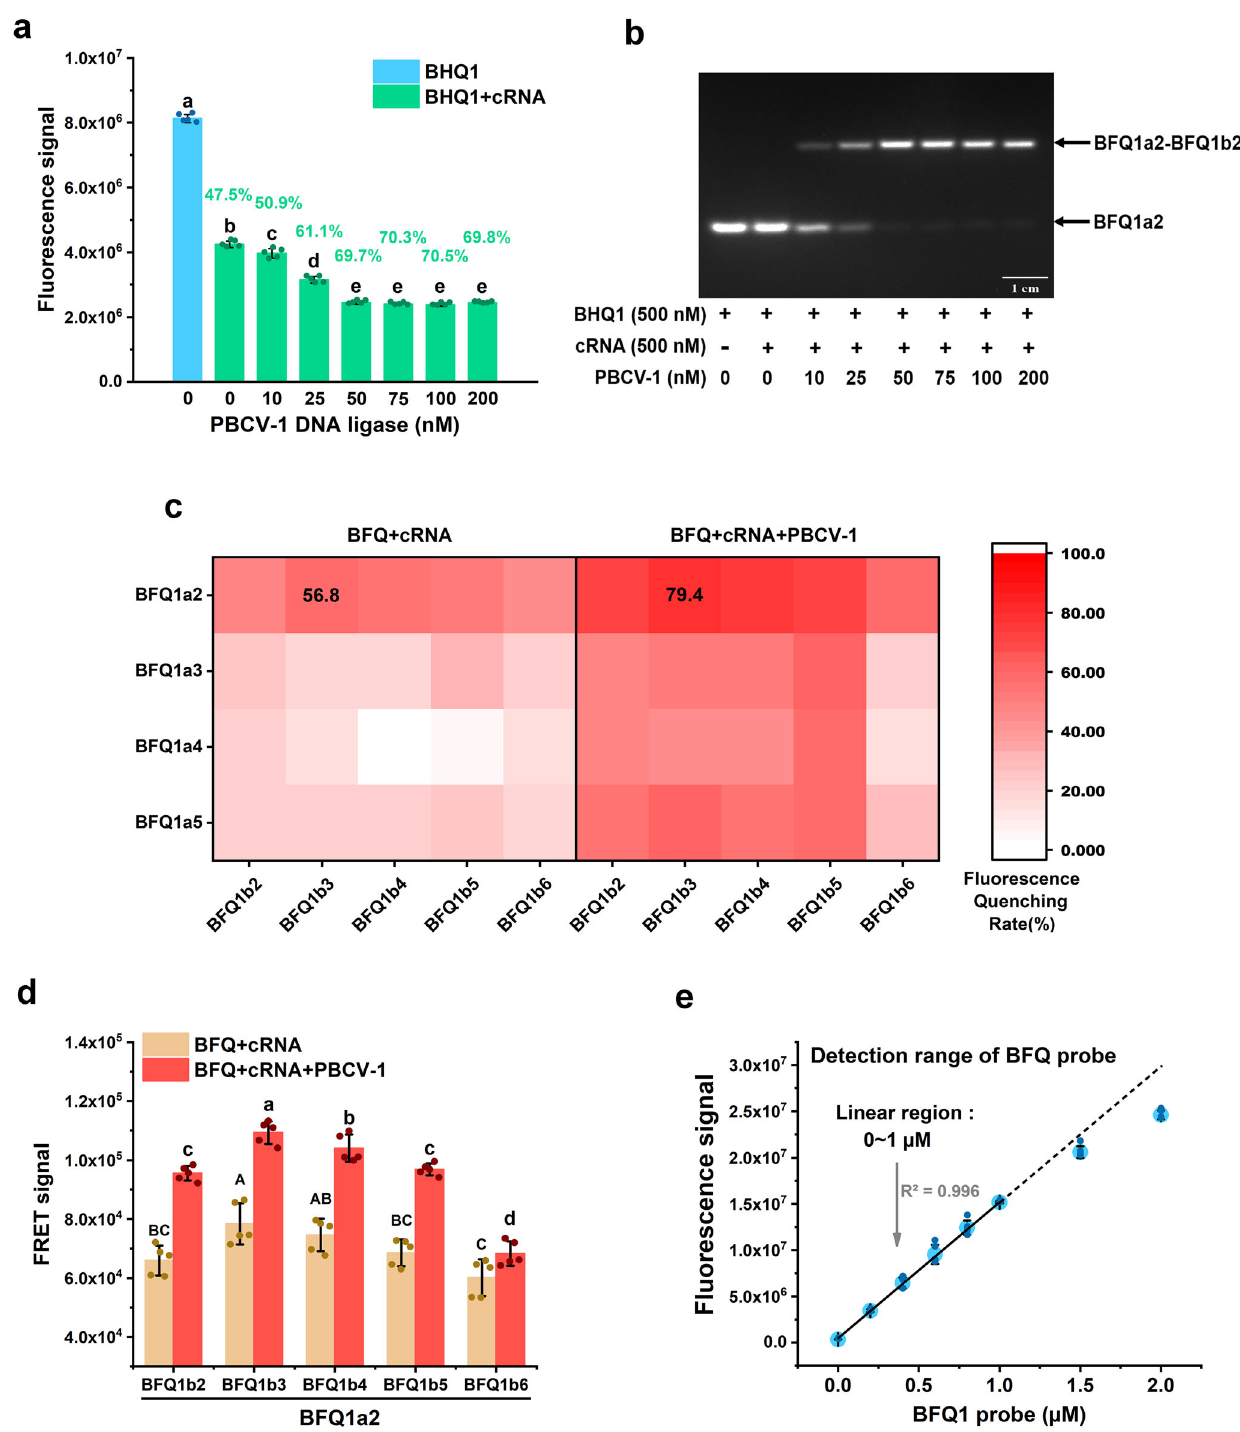
Fig. 2 BFQ and PBCV-1 DNA ligase can be used for RNA quanti fi cation in IVT reactions. a Addition of PBCV-1 DNA ligase facilitated FRET ef fi ciency in the detection system. 500 nM BFQ1 (BFQ1a2 and BFQ1b2), 500 nM cRNA, and different concentrations of PBCV-1 DNA ligase were mixed in transcription buffer and tested using a RT-PCR thermocycler with its FAM scan channels. Fluorescence quenching rates were calculated by the fl uorescence quenching value of each group divided by the fl uorescence value of only the BFQ1 group and is displayed in the corresponding position of the picture. Different letters indicate signi fi cant differences among PBCV-1 DNA ligase concentrations according to Duncan ’ s test ( p < 0.05, n = 5). b The RNA-splinted DNA ligation assays for different concentration of PBCV-1 DNA ligase. c Con fi rmation of fl uorophore labeling positions in the BFQ probes. The sequence and fl uorophore labeling positions are shown in Table 1. The fl uorescence quenching rate refers to the ratio of the fl uorescence quenching value of each group to the fl uorescence value of the corresponding BFQ1a probe and is displayed in the corresponding positions. d The FRET quenching signal of BFQ1a2 with BFQ1b2-BFQ1b6. Different letters indicate signi fi cant differences among PBCV-1 DNA ligase concentrations and fl uorophores labeling positions adjusted according to Duncan ’ s test ( p < 0.05, n = 5). e Detection range identi fi cation of BFQ. Different concentrations of BFQ1 (BFQ1a2 and BFQ1b3) were mixed in transcription buffer and tested using a RT-PCR thermocycler. All of the values shown represented the mean ± standard deviation of the results from fi ve independent